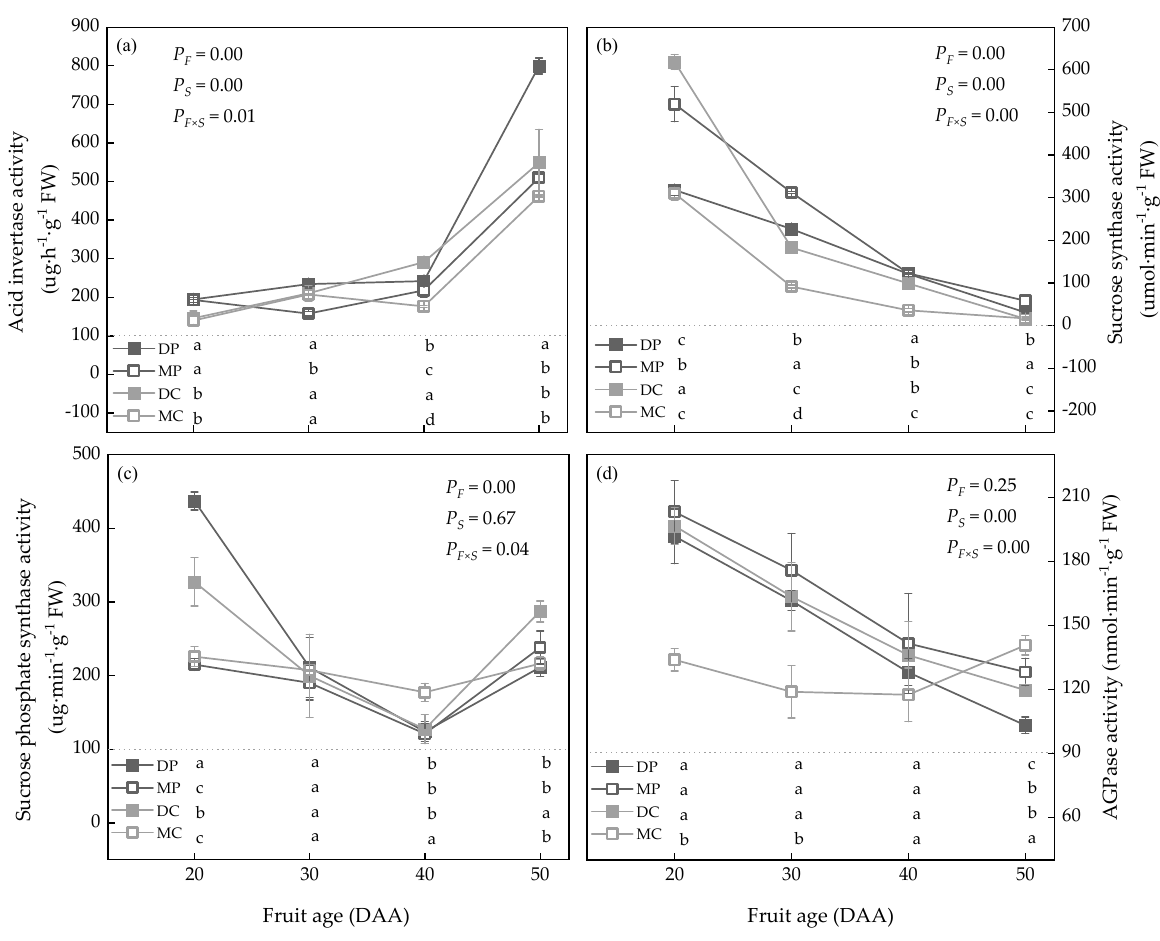
Figure 3. The profiles of acid invertase ( a ), Sucrose synthase ( b ), Sucrose phosphate synthase ( c ), and Adenosine glucose pyrophosphorylase (AGpase) activities ( d ) in tomato fruit (Different superscripts in each treatment indicated significant differences at p < 0.05).